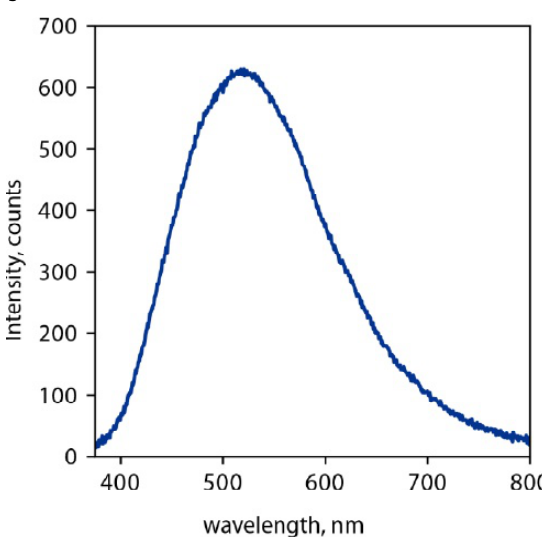
Fig. 2. Photoluminescence emission spectrum upon excitation at 320 nm. The wavelength of lumines- cence band peak is 514 nm.